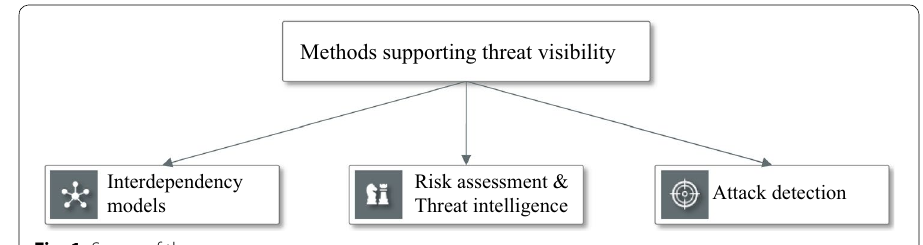
Fig. 1 Scope of the